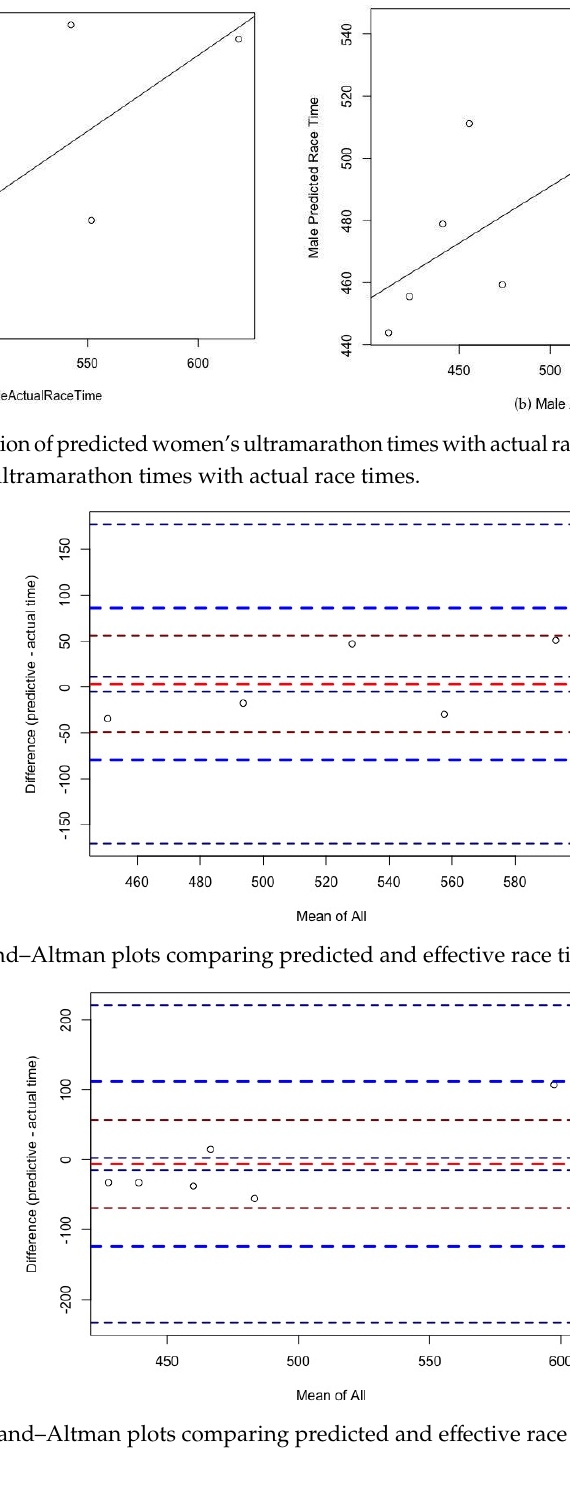
Figure 3 . Bland – Altman plots comparing predicted and effective race times for men.